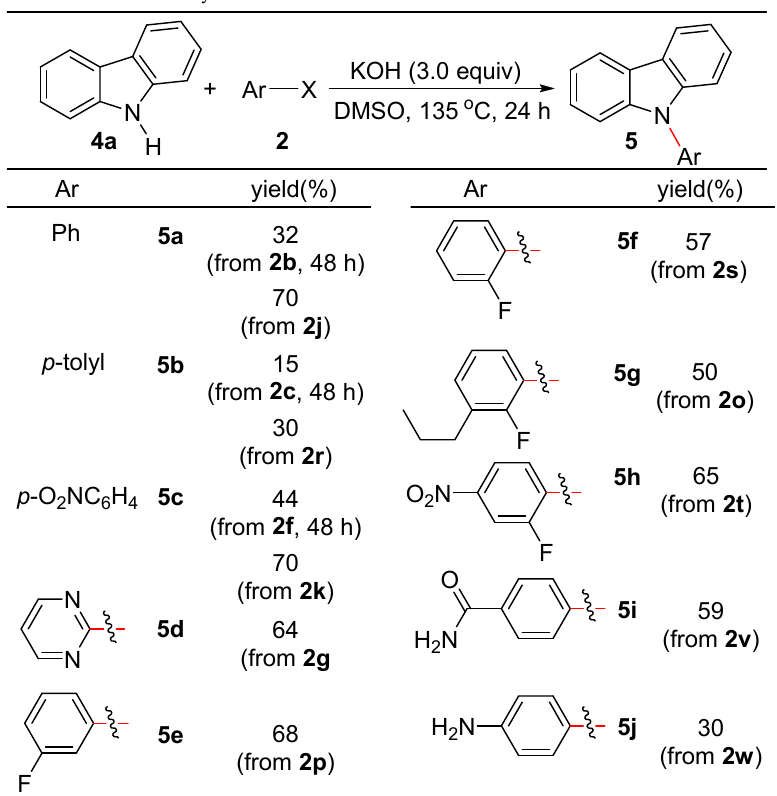
Table 3. N -Arylation of carbazole with chloro- and fluoroarenes